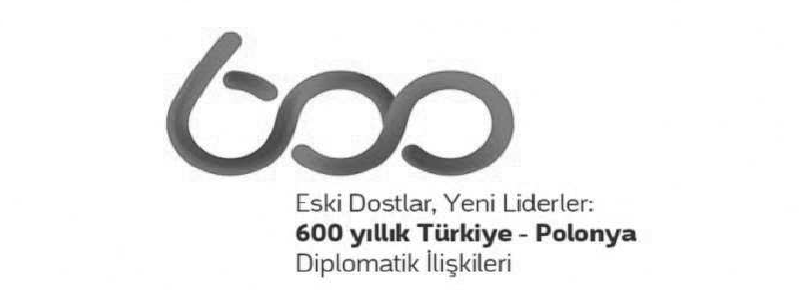
Fig. 11. Studio (cid:250) magina: 600 th anniversary emblem and logotype design of Tur- kish and Polish Diplomatic Relations.